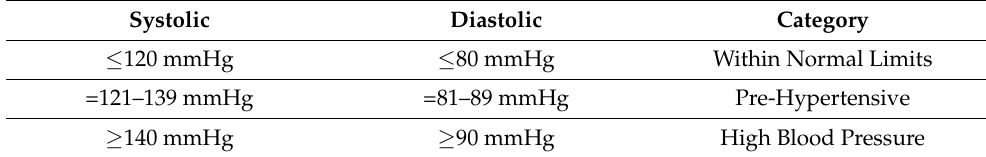
Table 2. Blood Pressure Measures and